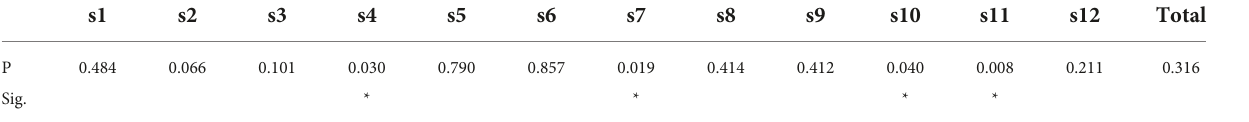
TABLE 8 Non-parametric independent samples tests (Mann–Whitney U